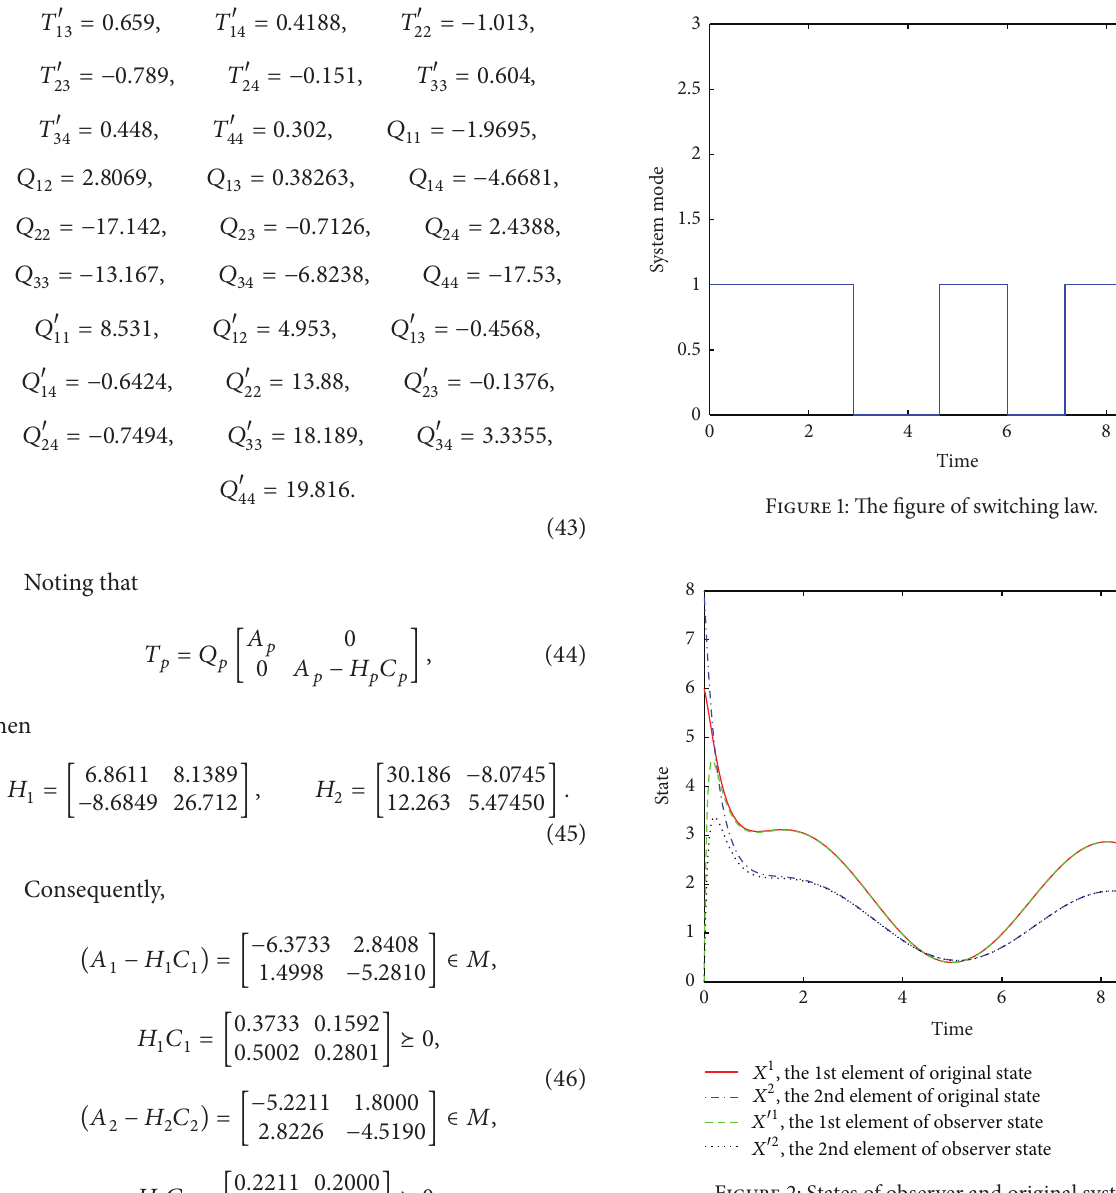
Figure 2: States of observer and original